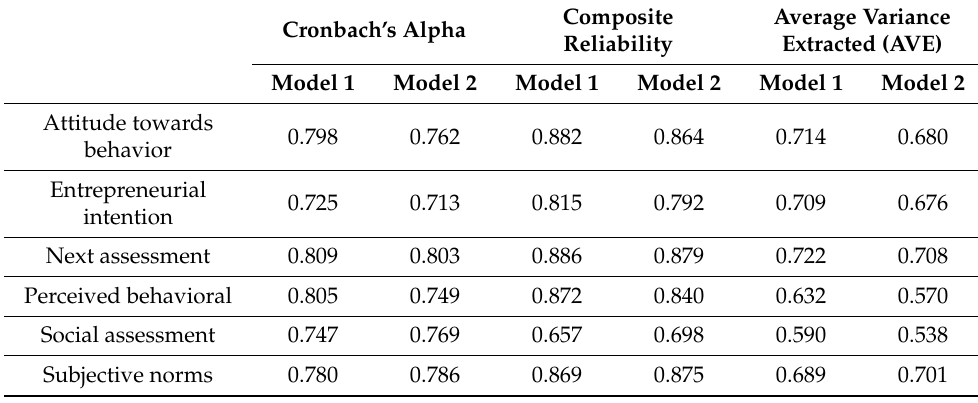
Table 6. Measures of reliability and validity of each of the scores.